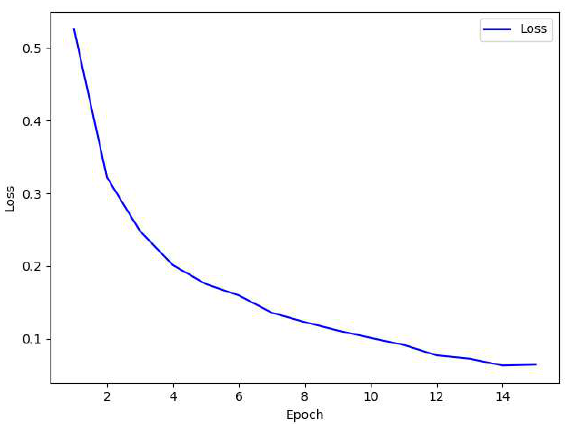
Figure 9. Per epoch loss for the optimized bidirectional